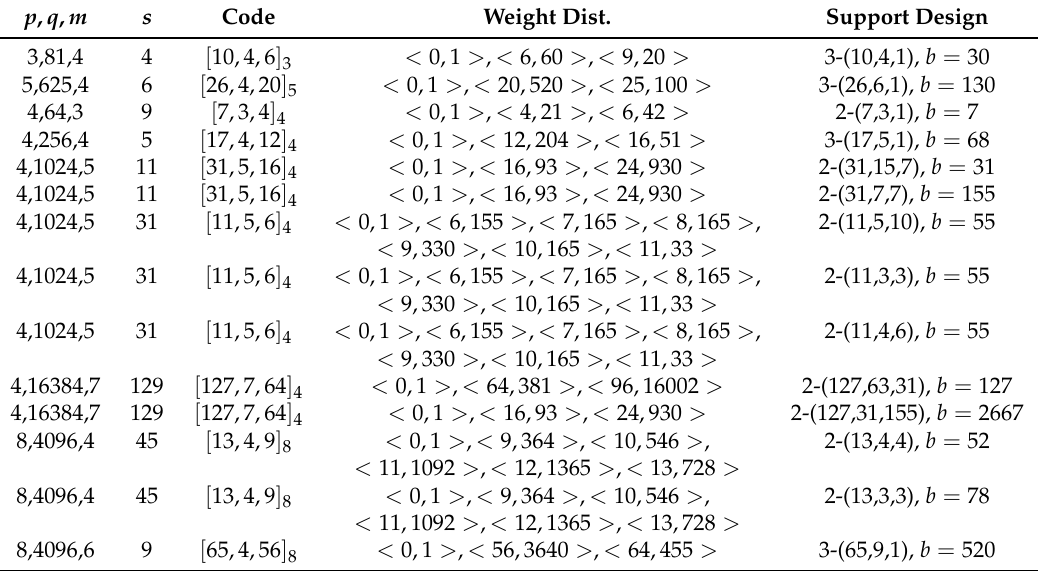
Table 9. Support